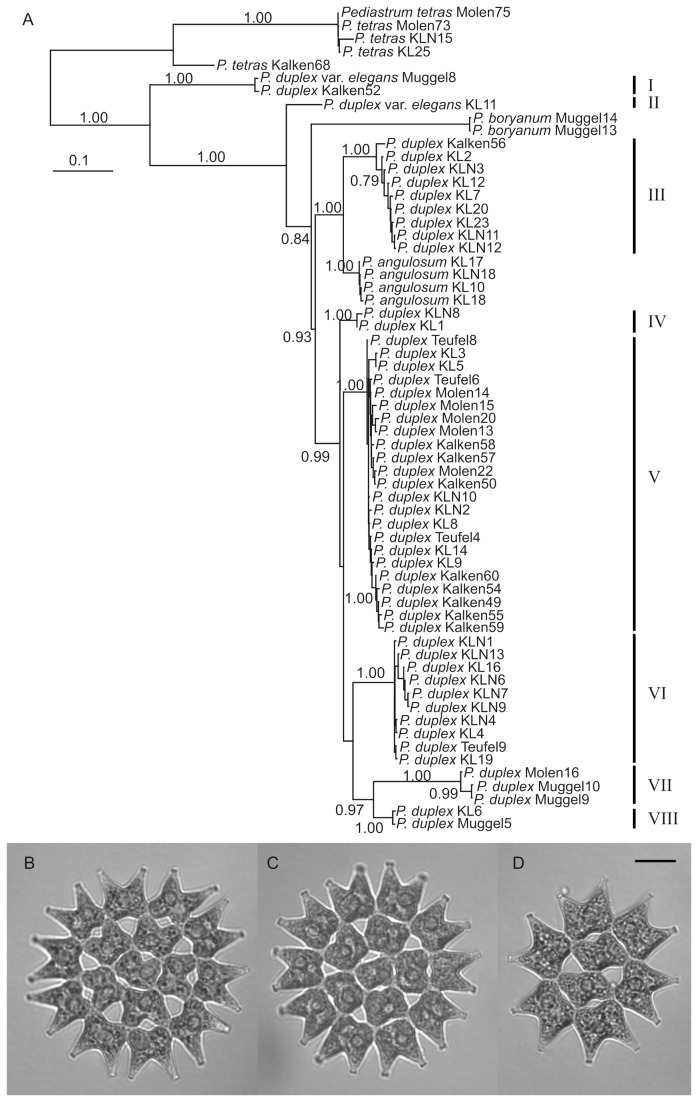
ITS rDNA phylogeny of Pediastrum strains (A) and light microscopy photographs of three of the Pediastrum duplex strains from lineage V (B-D), used to study sensitivity to polyphenolic allelochemicals.(A) Most likely phylogeny from a Bayesian Inference analysis. Posterior probabilities > 0.70 are shown at the respective nodes. The different P. duplex lineages recovered are numbered I-VIII. (B) Pediastrum
duplex strain KL5, (C) Kalken49, (D) Molen20.